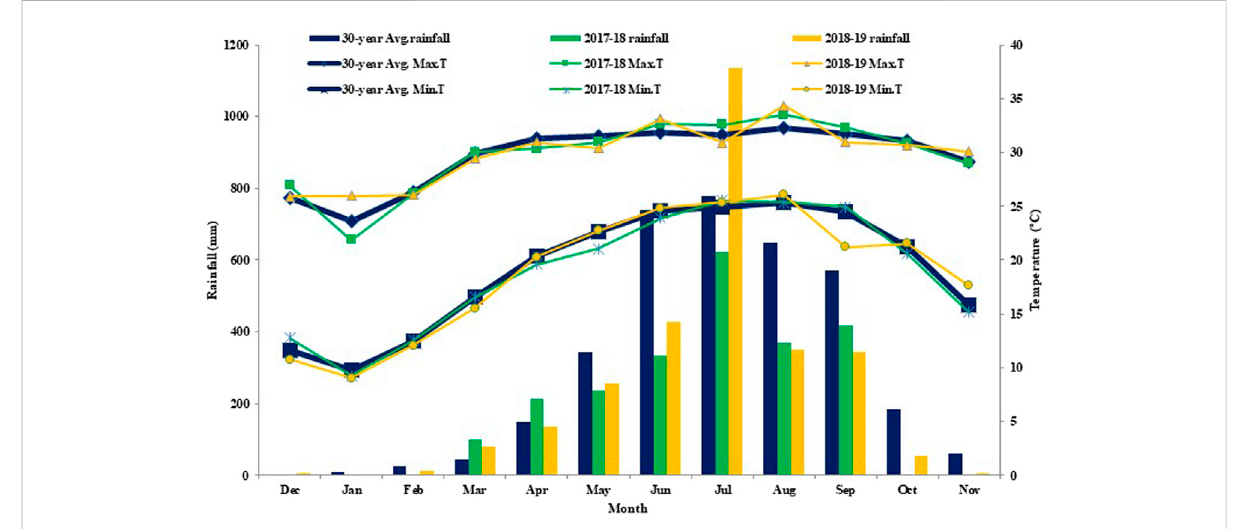
FIGURE 2 Monthly average rainfall (bar) and maximum and minimum temperatures (line) in 2017 – 18, 2018 – 19, and 30-year average.